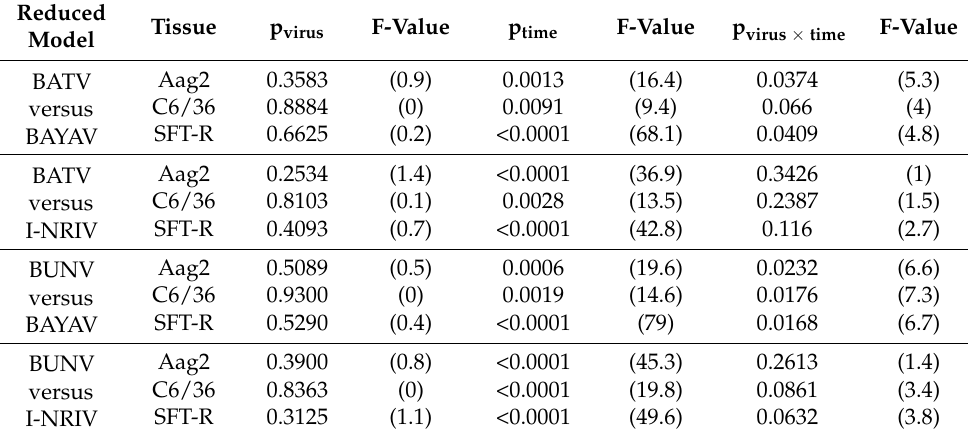
Table 2. Reduced model comparing all four viruses in selected cell lines. Due to four subgroup analyses following non-significant results in the full model, a p -value smaller than a Bonferroni- corrected significance level of 0.05/4 = 0.0125 is considered